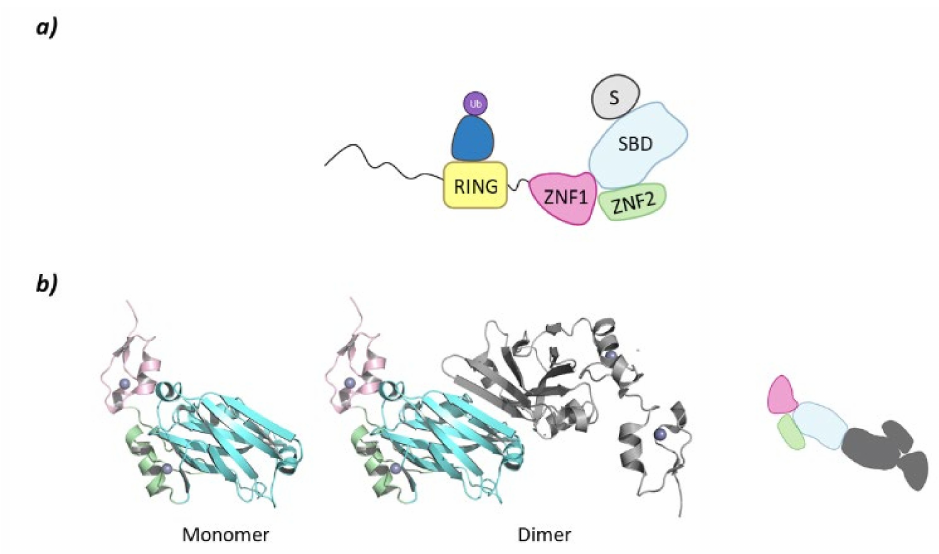
Figure 9. SIAH2. ( a ) Schematic representation of the assembly of a monomer of the SIAH2 E3 ligase: ubiquitin (Ub) in purple, E2 ligase (E2) in dark blue, Ring domain (RING) in yellow, zinc finger domain 1 (ZNF1) in pink, zinc finger domain 2 (ZNF2) in green, substrate binding domain (SBD) in light blue, and substrate protein in grey. ( b ) 3D representation of the dimerization of SIAH2 by the SBD as found in PDB code 5H9M. One of the monomers of the homodimer is colored following the existing color code, and for clarity, the second monomer has been colored